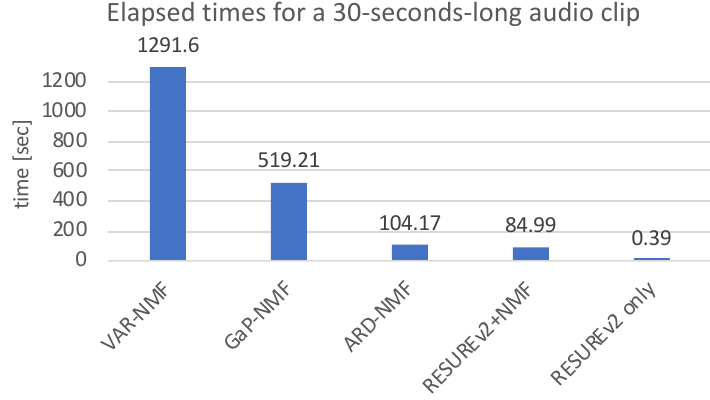
Figure 13. Comparison chart for elapsed times of algorithms. The elapsed times were measured for processing a 30-second-long audio clip using MATLAB on a laptop with a 3.5-GHz dual-core CPU and 16-GB